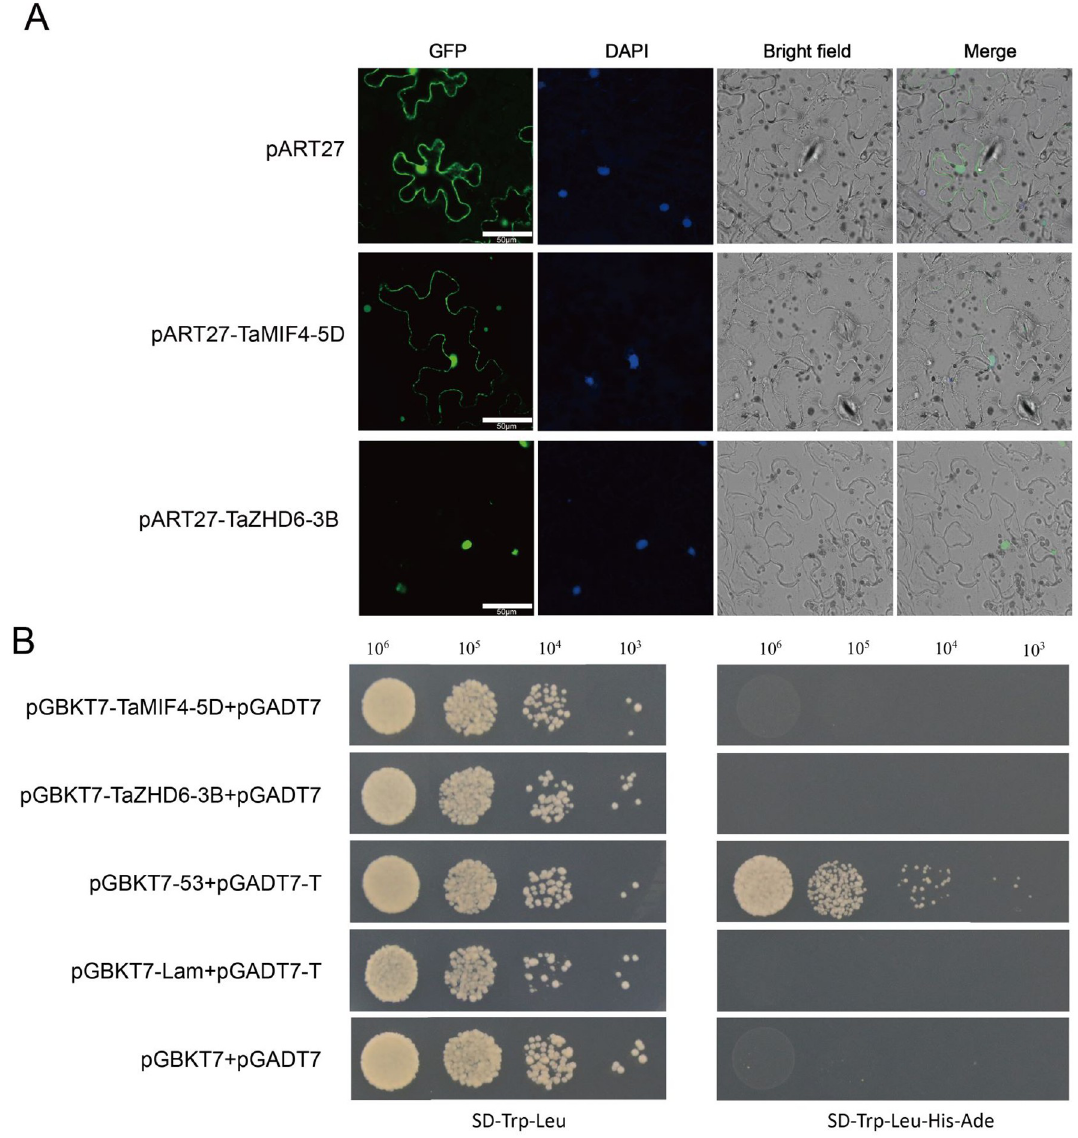
Fig 8. Subcellular localization and verification of transcriptional autoactivation activity of TaMIF4-5D and TaZHD6-3B. ( A ) Subcellular localization of TaMIF4-5D and TaZHD6-3B. The figure shows the fluorescence signal of GFP, the fluorescence signal after DAPI staining, the bright field and the fusion image, respectively. The fluorescent signal of GFP in the figure is used to mark the expression position of the fusion proteins. The fluorescent signal after DAPI staining is used to show the position of the cell nucleus. Scale bar = 50 μ m. ( B ) Verification of TaMIF4-5D and TaZHD6-3B transcriptional autoactivation activity. The concentrations (cells/ ml) of yeast transformants were adjusted to 10 6 , 10 5 ,10 4 ,10 3 , respectively.